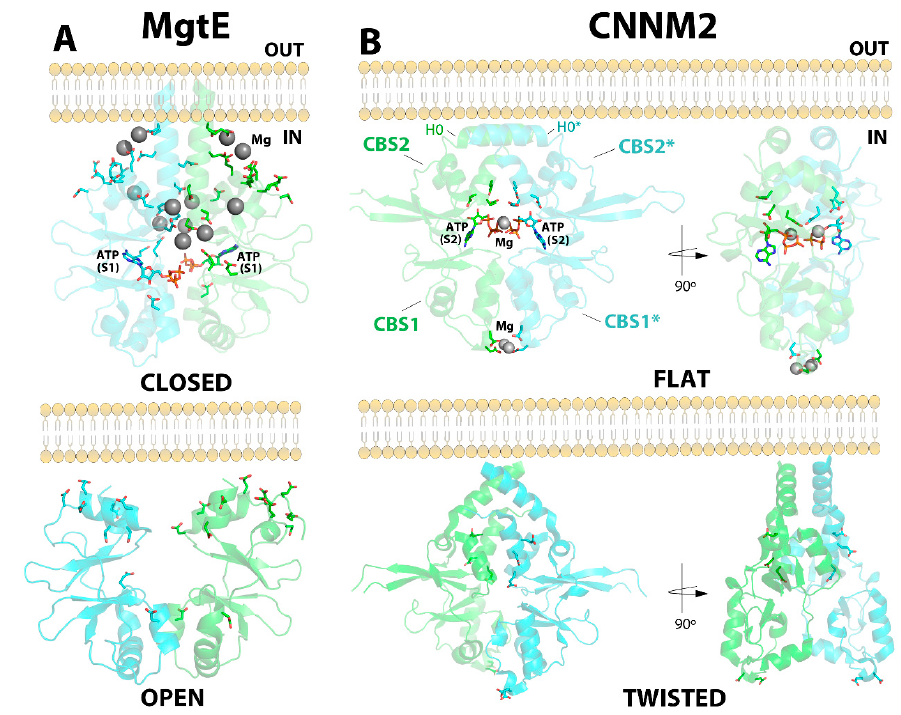
Figure 5. Structural comparison of CNNM2 and MgtE. ( A ) Structure of the CBS module of MgtE in its two different conformations: ( top ) closed and ( bottom ) open. Mg 2+ ions are represented by grey spheres. The acidic clusters are represented by sticks. Upon binding of Mg 2+ ions, the CBS module evolves from its open state (bottom) to its closed Mg 2+ -bound conformation (top). ( B ) CNNM2 may adopt two different conformations: Flat (top right) when bound to MgATP, and twisted (bottom right) in the absence of a nucleotide. The main residues involved in ATP and Mg 2+ binding are represented by